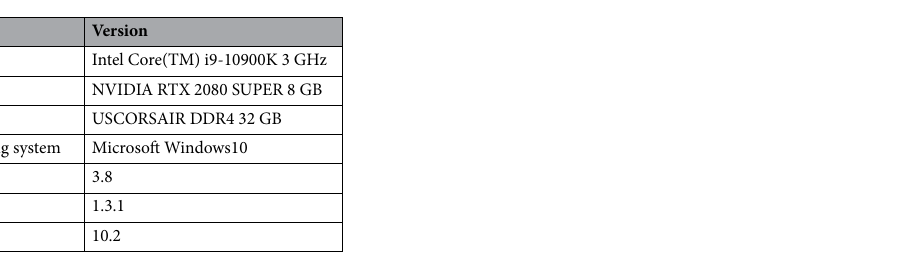
Table 1. Configuration of experimental